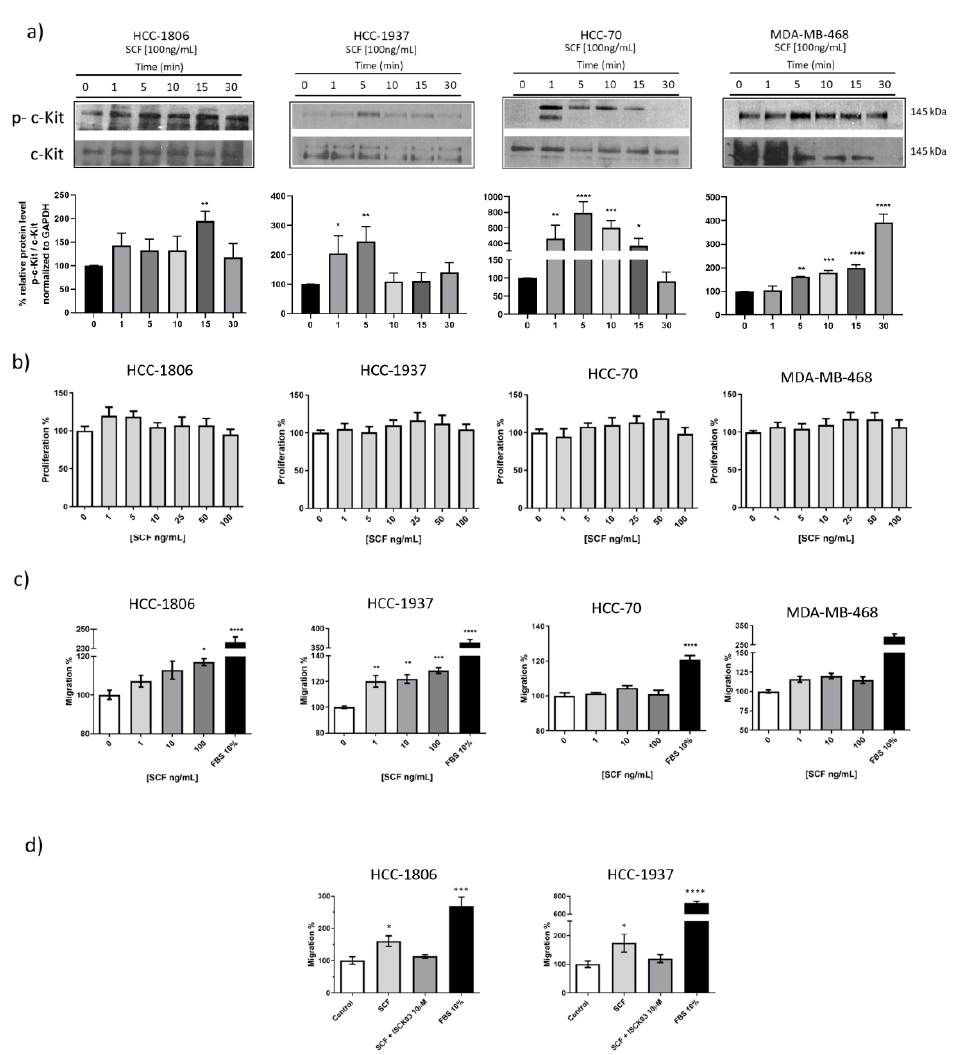
Figure 2. Effect of c-Kit activation on TNBC cell proliferation and migration. ( a ) Time-course of c-Kit activation by SCF. HCC-1806, HCC-1937, HCC-70, and MDA-MB-468 cells were incubated with 100 ng/mL SCF. Phosphorylation of the receptor was evaluated by Western blotting at the indicated time points. Densitometric analysis indicated as percentage is shown below each blot. ( b ) For the proliferation assay, the cells were treated with increasing concentrations of SCF. Cell proliferation was evaluated at 48 h using the MTT colorimetric assay. ( c ) The migration of cells was evaluated using the Boyden chamber assay using 1, 10, and 100 ng/mL SCF, 10% FBS as positive control, or FBS-free medium as negative control that were loaded into the lower chambers. Cell migration was evaluated after 24 h. ( d ) To inhibit c-Kit phosphorylation, HCC-1806 and HCC-1937 cells were pre-incubated with 10 µM ISCK03. Cell migration was then evaluated by Boyden chamber assays using FBS-free medium (Control), 100 ng/mL SCF (SCF), 100 ng/mL SCF, and the indicated concentration of ISCK03 (SCF + ISCK03 10 µM), or 10% FBS. Values represent the average of three independent experiments. Error bars indicate the standard error of the mean. * p < 0.05, ** p < 0.005, *** p < 0.0005, and **** p < 0.0001 vs. negative control values (Dunnett test).